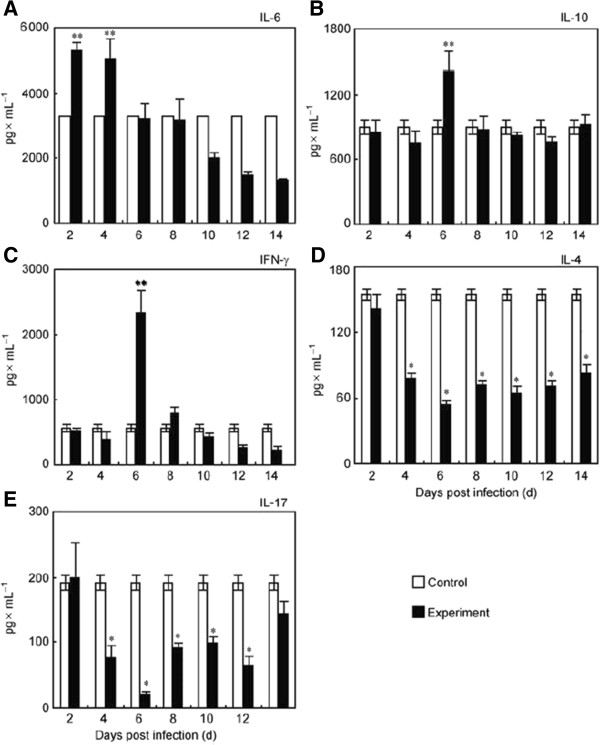
Determination of cytokine levels in mice after fatal dose (5 × 105 p.f.u.) of A/PR/8/34 (H1N1) virus infection. IL-6 (A), IL-10 (B), IFN-γ (C), IL-4 (D), and IL-17 (E). Mice without infection were used as the control group. The dotted lines represented the results of control group. Columns represented mean cytokine concentrations representative of 5~6 mice, and I bars indicated the standard deviations. *p < 0.05, compared with control group.